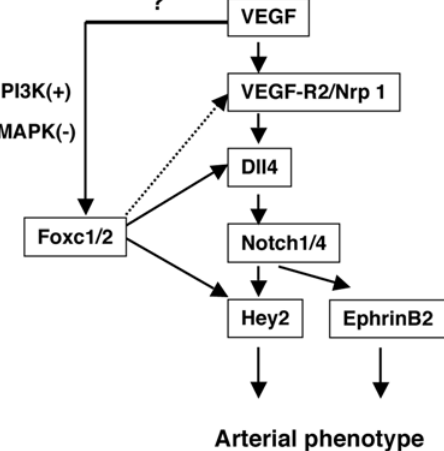
Figure 5. Model for the involvement of Foxc proteins in arterial gene expression program. Upon VEGF stimulation, the expression of Notch signaling genes, including the Dll4 ligand and the Notch1/4 receptors, as well as downstream targets of Notch signaling, including Hey2 and ephrinB2 [44], is induced in endothelial cells. Foxc1 and Foxc2 transcription factors directly control Dll4 and Hey2 transcription, while it remains speculative whether Foxc proteins function downstream of VEGF. Foxc2 is involved in the Su(H)-NICD transcriptional complex for the induction of Hey2 expression. Foxc proteins may also regulate expression of Nrp1, the arterial-specific co-receptor for VEGF (dashed arrow), thereby controlling the positive feedback loop of VEGF signaling.